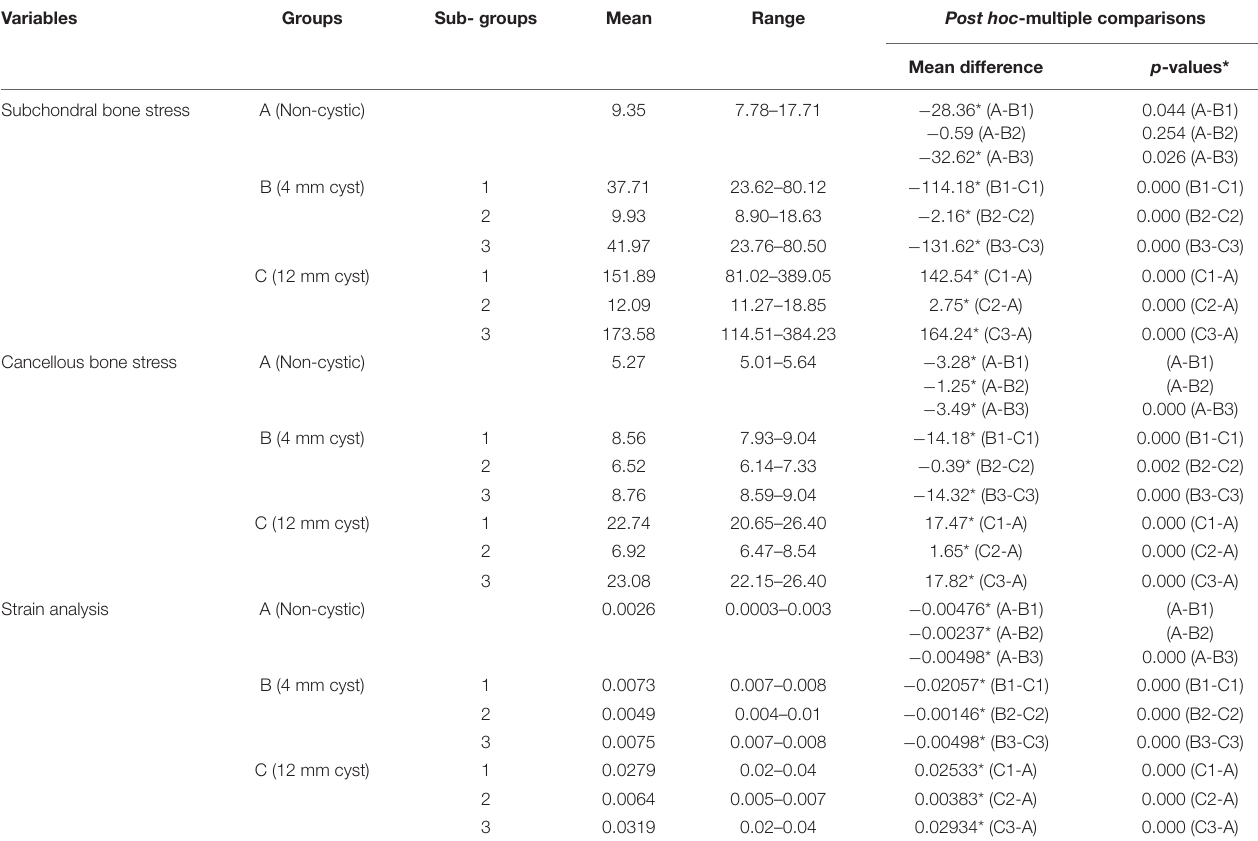
TABLE 3 | Statistical analysis of stress in subchondral and cancellous bone and cystic